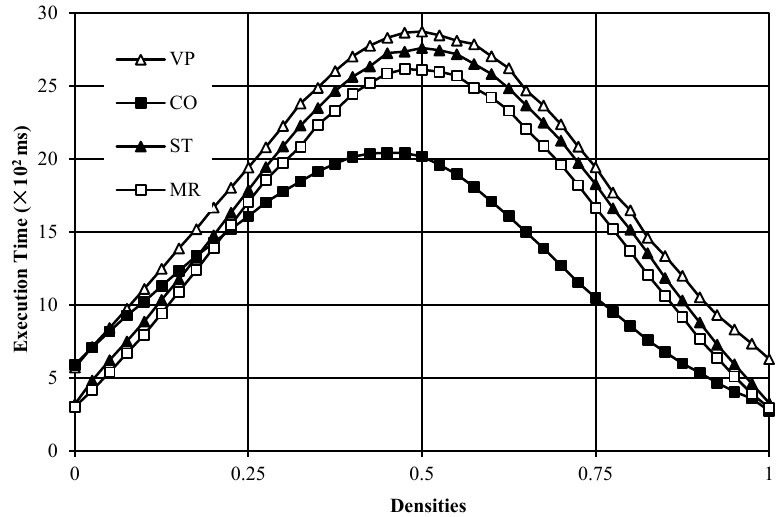
Figure 10. Execution time versus image densities of foreground voxels.